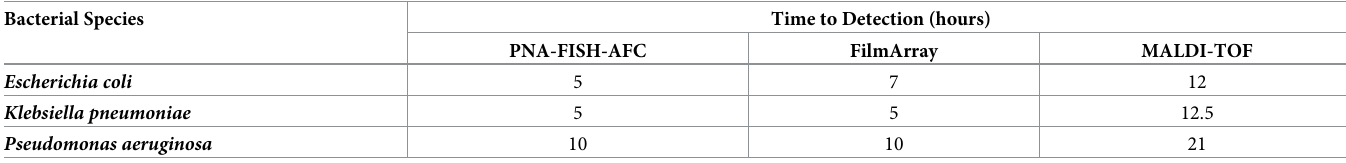
Table 5. Earliest time to detection using different diagnostic assays. Bacterial